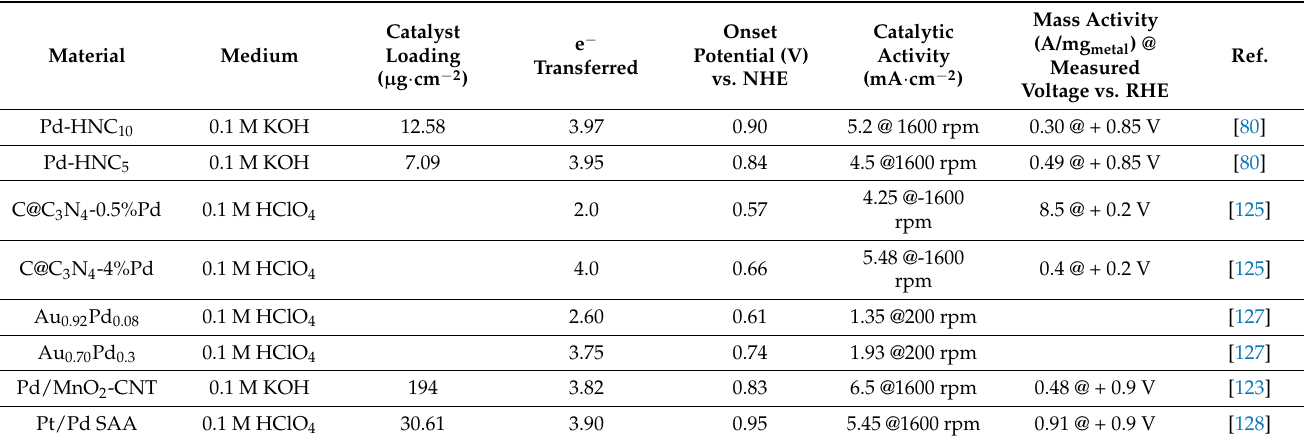
Table 4. Summary of ORR activity of some Pd-based Single Atom Catalysts in acidic/alkaline solutions.